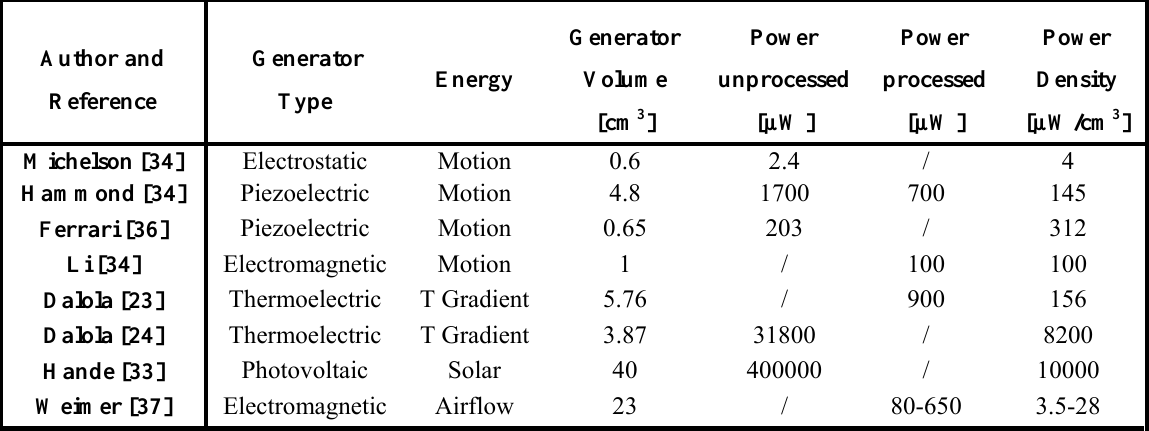
Table 1. Comparison of published power harvesters for autonomous